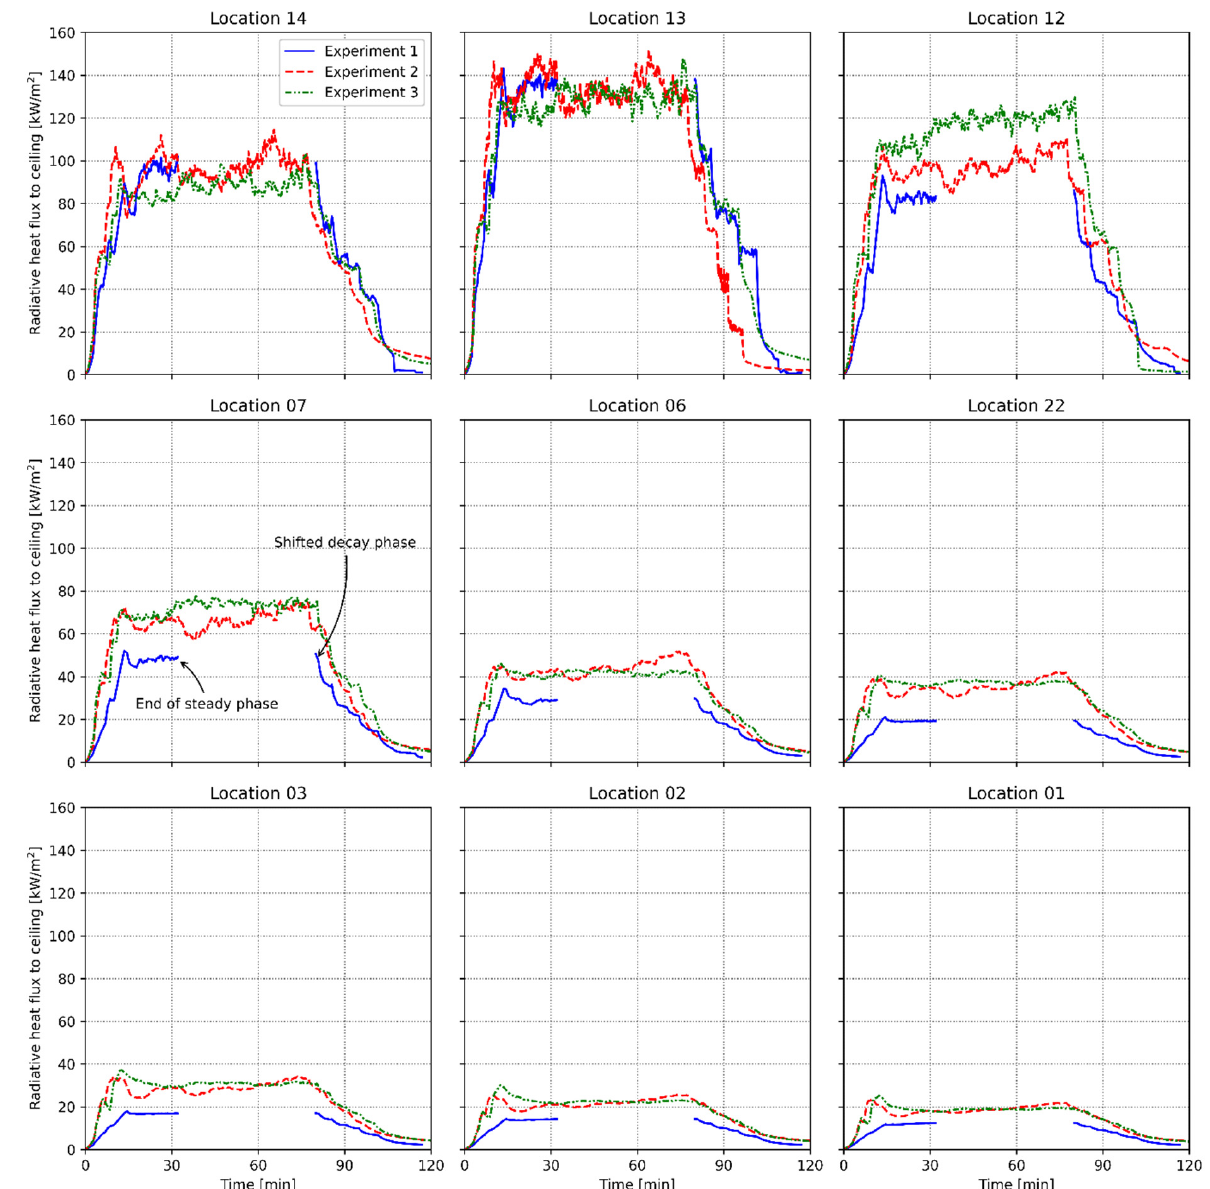
Figure 15. Radiative heat flux to ceiling estimated from PT measurements in Experiments 2 and